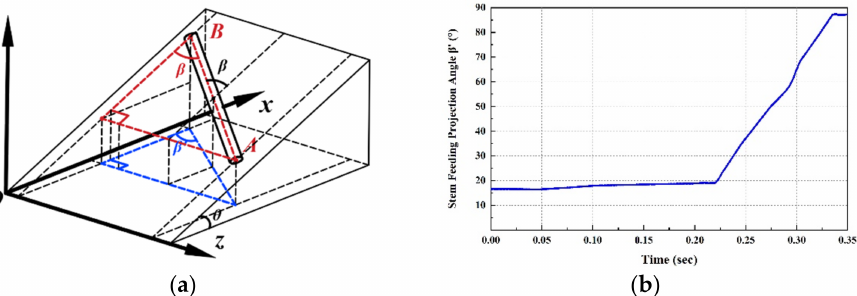
Figure 11. The schematic diagram and curve of the angle β (cid:48) . ( a ) Schematic diagram of the stem pos- ture angle β and its projection angle β (cid:48) . ( b ) Curve of the projection angle β (cid:48) during stem transported- posture adjustment